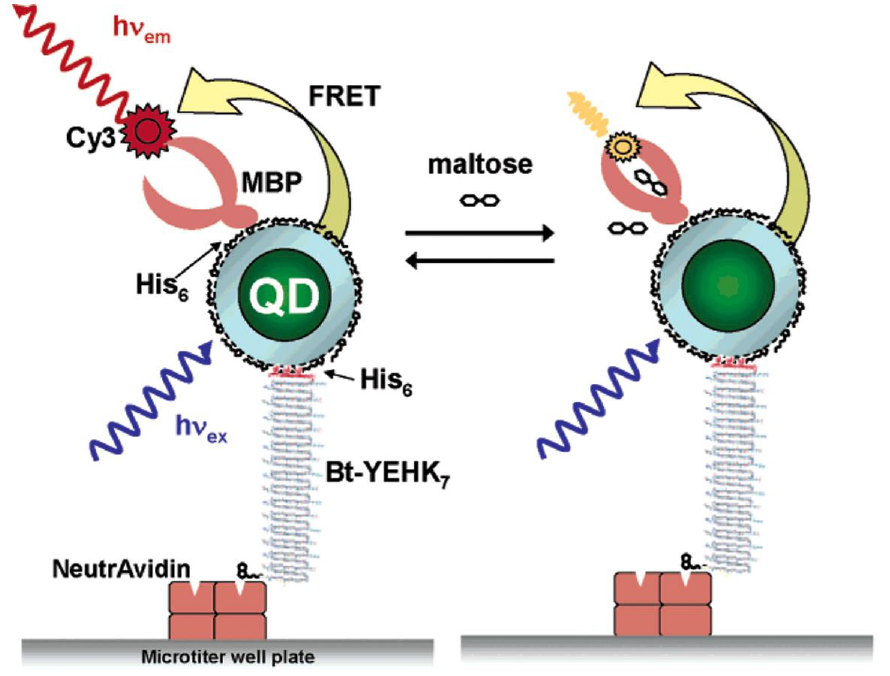
Figure 5. Schematic illustration of a FRET-based surface-immobilized maltose biosensor: QDs captured in NeutrAvidin-coated microtiter well plates functionalized with biotinylated peptide (Bt-YEHK ) were subsequently self-assembled with a mutant dye-labelled maltose 7 binding protein (MBP), enabling the detection of maltose due to changes in Cy3 emission (Reprinted with permission from [92], Copyright 2006 American Chemical